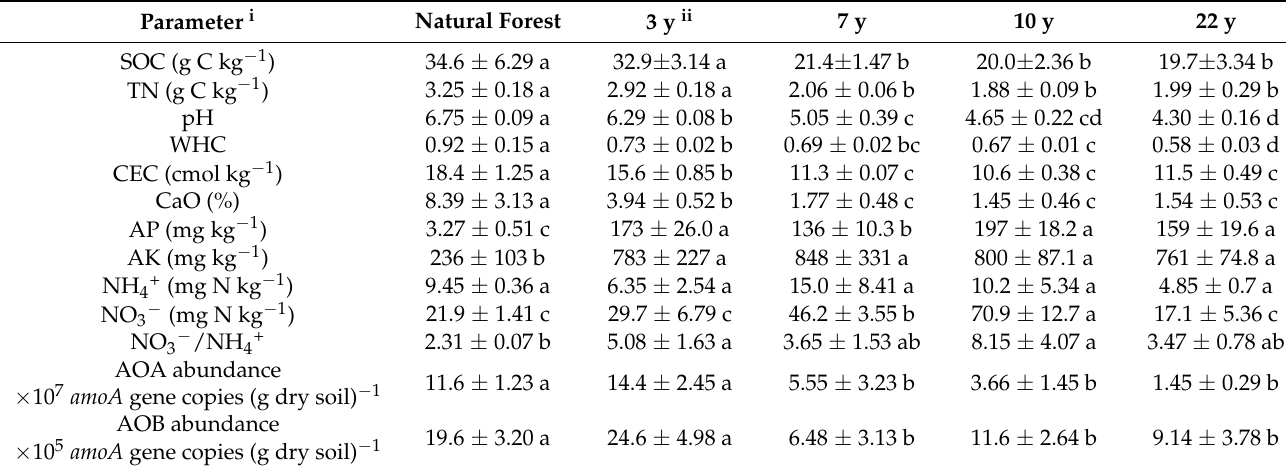
i SOC, soil organic C; TN, total N; WHC, water holding capacity; CEC, cation exchange capacity; AP, available P; AK, available K; AOA, archaeal amoA gene; AOB, bacterial amoA gene. ii 3, 7, 10, and 22 y represent the cultivation durations of the banana plantations that were converted from natural forests. Identical letters for the same value indicate that there were no significant differences in the soils under natural forest conditions and in the four banana plantations in the same region at p =